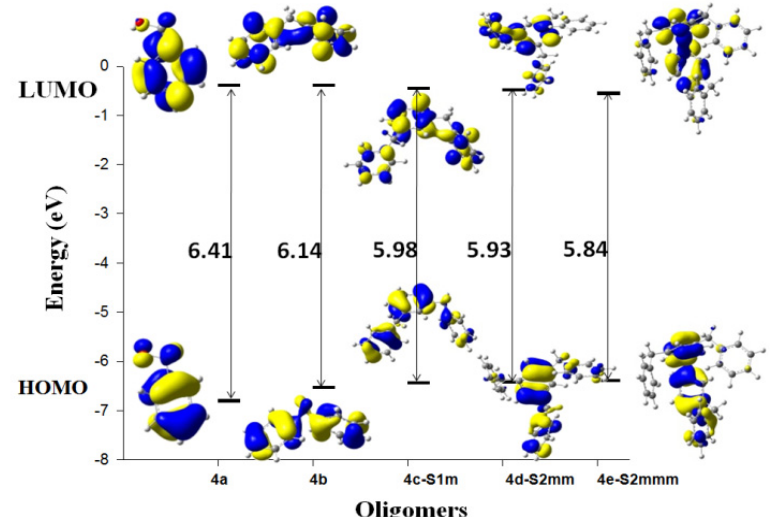
Figure 3. Sketch of B3LYP/6-311G(d,p) calculated energies HOMO, LUMO levels.